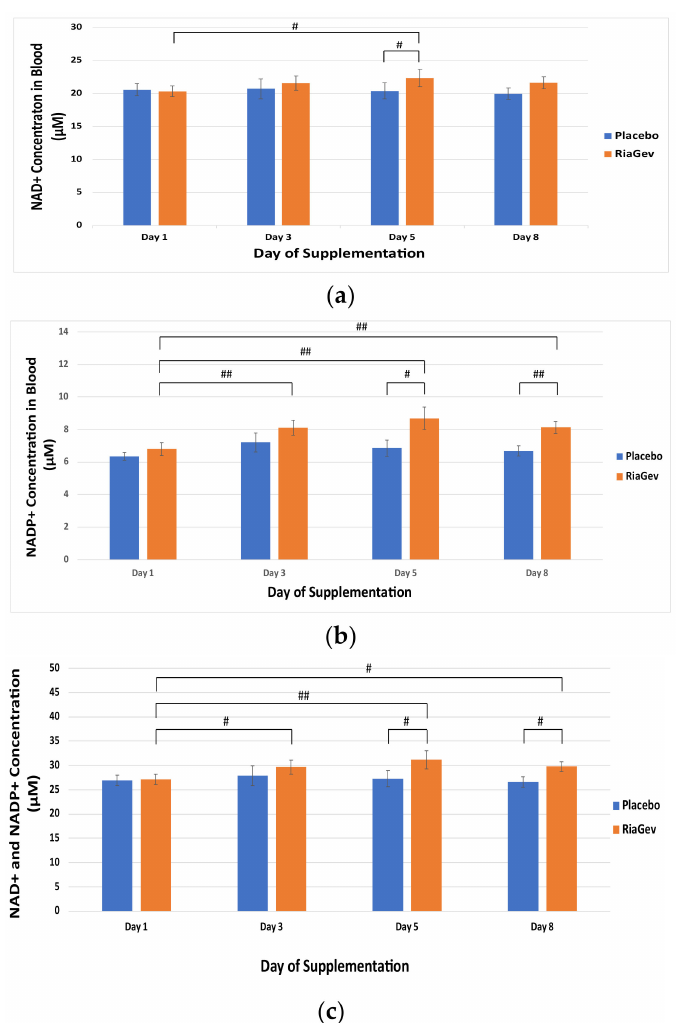
Figure 2. Whole Blood NAD + and NADP + Concentrations on Days 1, 3, 5, and 8 of the Clinical Trial. NAD + and NADP + levels are represented by solid bars with standard errors indicated. ( a ) NAD + concentration. ( b ) NADP + concentration. ( c ) Combined NAD + and NADP + concentration. Significant changes within the RiaGev group over time or significant differences between RiaGev and Placebo groups on the same day are marked by # ( p < 0.05) or ## ( p < 0.01). Compared with the mild increase in NAD + level, an unexpectedly dramatic increase in NADP + concentration was observed (Figure 2b). Significant within-group increases of 19.1%, 27.6%, and 19.6% were recorded with RiaGev group at Days 3, 5, and 8 over baseline, respectively ( p ≤ 0.008). The NADP + concentrations for the RiaGev group are also significantly greater than that of Placebo group at Day 5 and 8 ( p ≤